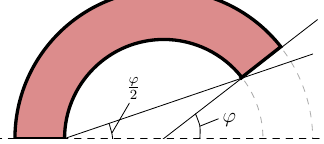
Figure 1. Definition of the opening angle ϕ in an idealized, symmetric arterial geometry.